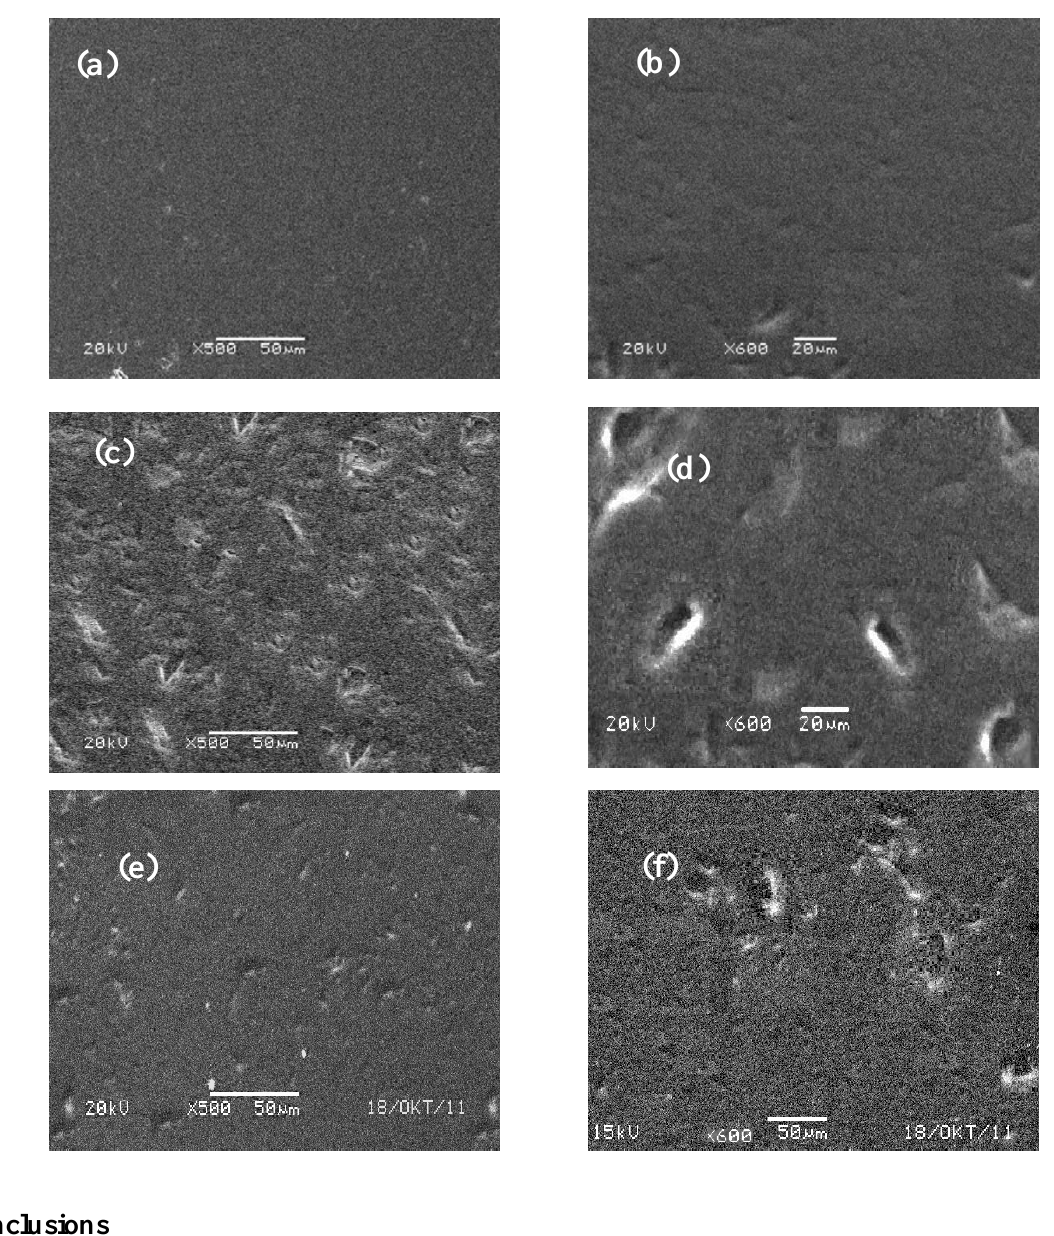
Figure 7. ( a , b ) Scanning Electron Microscope (SEM) image of a Gel|C electrode; ( c , d ) SEM image of a Cat|Gel|C electrode; ( e , f ) SEM image of a Cat|Gel|C electrode which was soaked in a buffer solution for 24